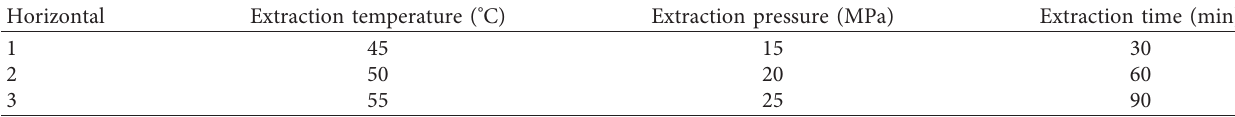
Table 5: Factor levels of supercritical extraction method.